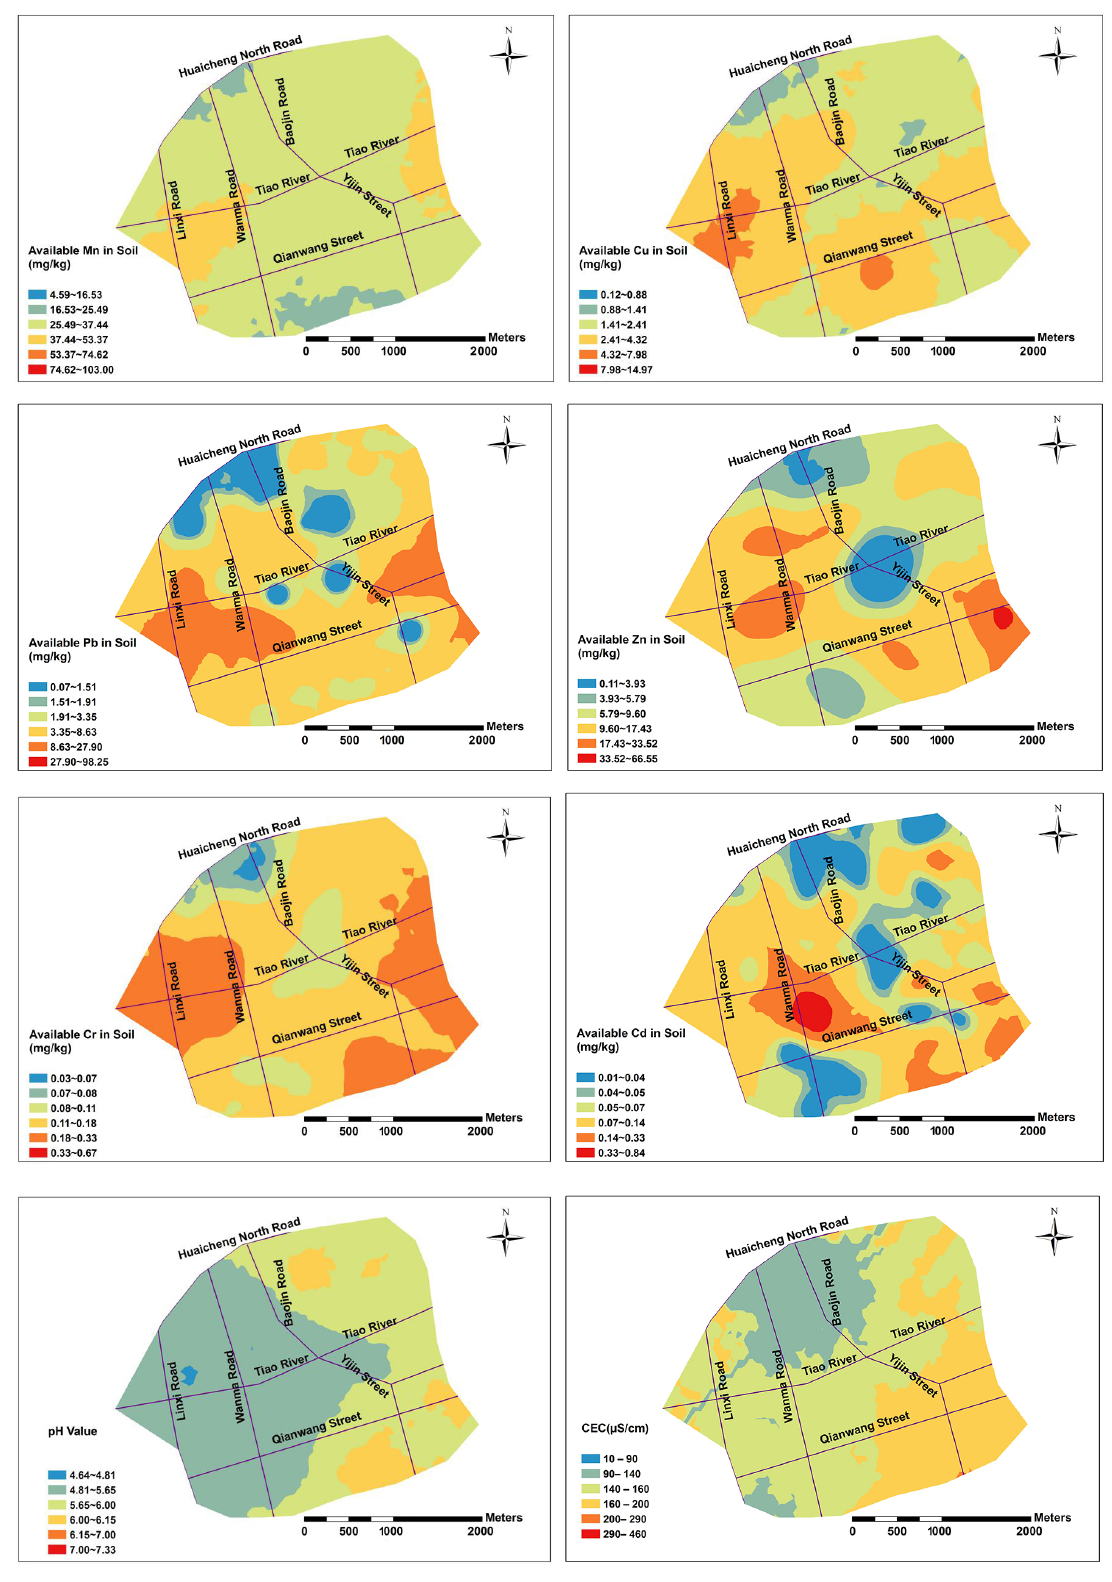
Figure 3. Spatial distribution maps of available fractions of PHMs, pH and CEC.